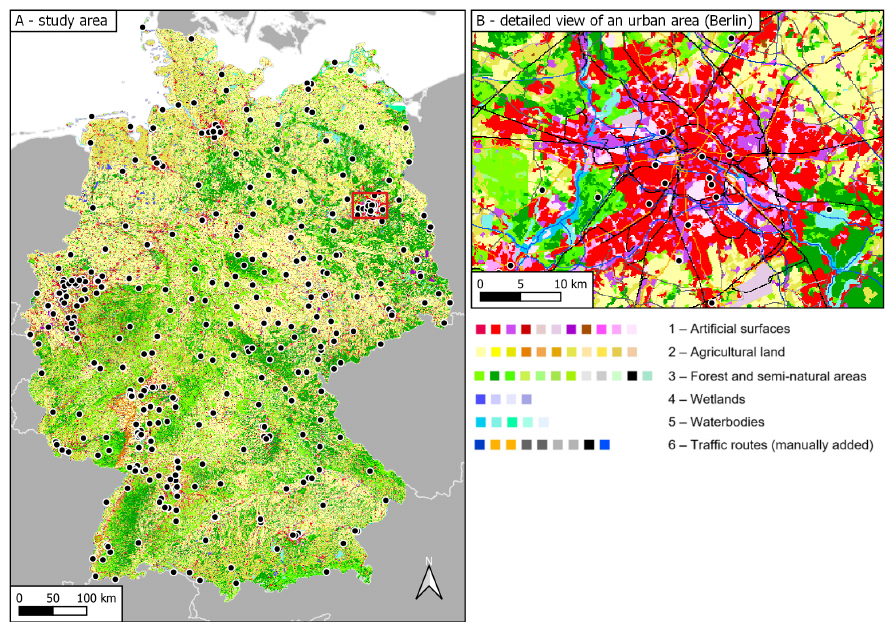
Figure 1. CORINE land cover in Germany ( A ), the metropolitan area of Berlin ( B ), and the locations of air quality stations (black dots) used in this study. Legend items are grouped by the first level of the official CORINE land cover class nomenclature. Each element within a group represents a third-level CORINE land cover class. A full legend with all items is provided in Appendix A. The items belonging to the first level 6 class (traffic routes) are only visible in map ( B ). The brown areas in the southwestern part of map ( A ) correspond to the third-level classes, 221 (vineyards) and 222 (fruit trees and berry plantations) belonging to the first level 2 class (Agricultural land).